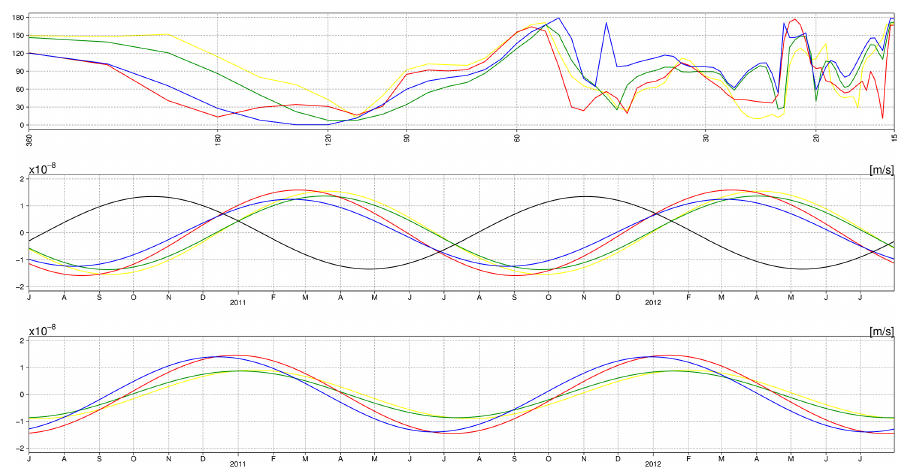
Figure 5. Top panel: phase analysis between Gibraltar transport and surface mass fluxes. Middle panel: Gibraltar transport for the four experiments and surface mass flux reconstructed using only seasonal frequencies. The black line indicates the surface mass fluxes (identical in all the model simulations). Bottom panel: sea’s surface height stochastic component for the four experiments reconstructed using only seasonal frequencies. NEMO-MFS1, red; NEMO-MFS2, blue; NEMO-MFS3, yellow; NEMO-MFS4,